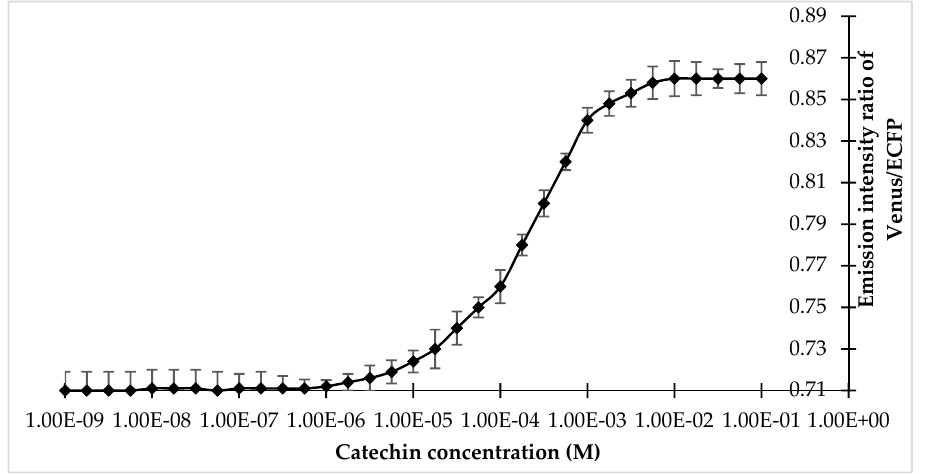
Figure 4. Titration curve of FLIP-Cat at different concentrations of (+)-catechin.Values are means of three independent replicates. Vertical bar indicates standard error.